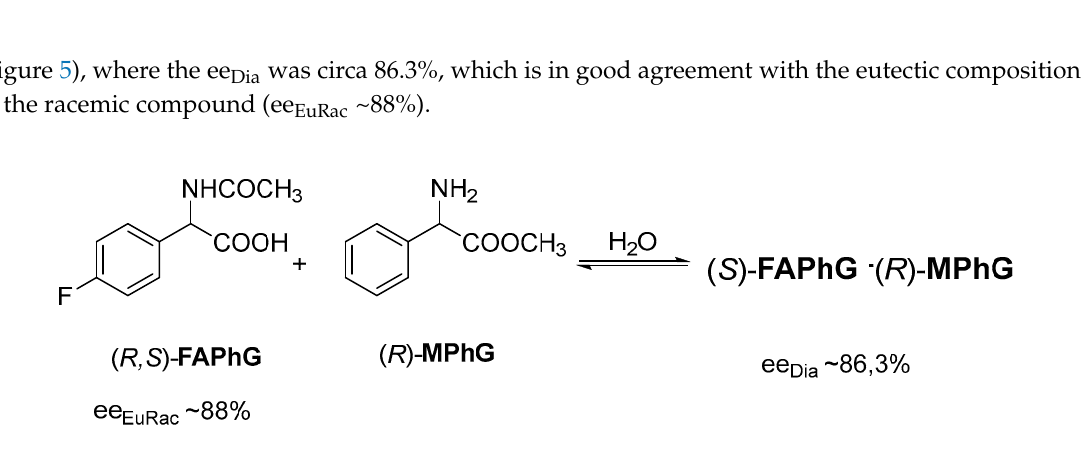
Figure 5. Diastereomic salt formation of ( R , S ) ‐ FAPhG with ( R ) ‐ MPhG resolving agent—similar eutectic composition of racemic and diastereomeric compound.